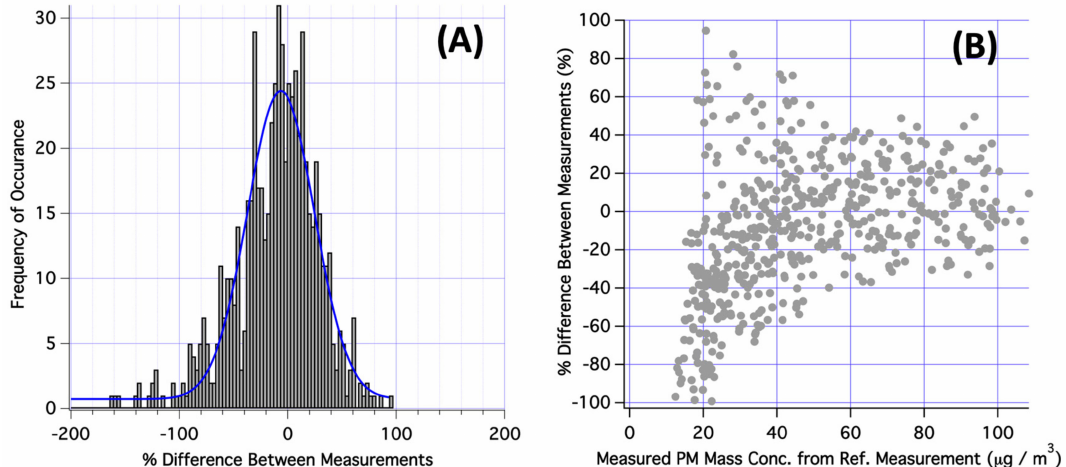
Figure 5. ( A ) Histogram of percent di ff erence between individual Sharp GP2Y1010AU0 dust sensor measurements and the reference method measurements (RAM-1) for test sodium chloride aerosol within a chamber. A Gaussian fit to the data indicated σ = 30.8 for the entire comparison dataset. ( B ) Plot of percent di ff erence between Sharp dust sensor and the reference measurement plotted vs. the indicated PM mass concentration for the reference method.